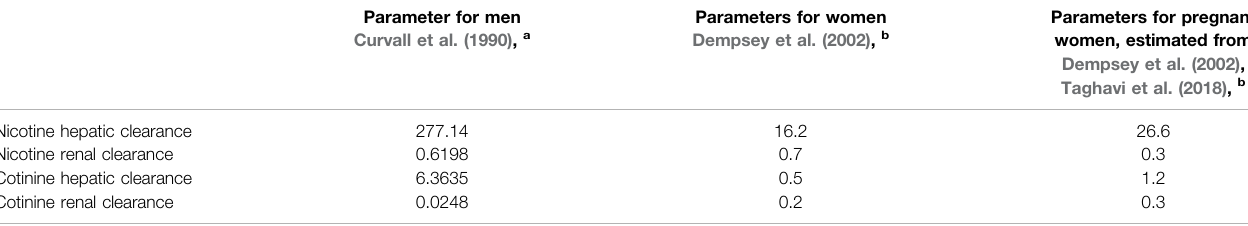
TABLE 1 | Nicotine and cotinine hepatic and renal clearance parameters used in the model.